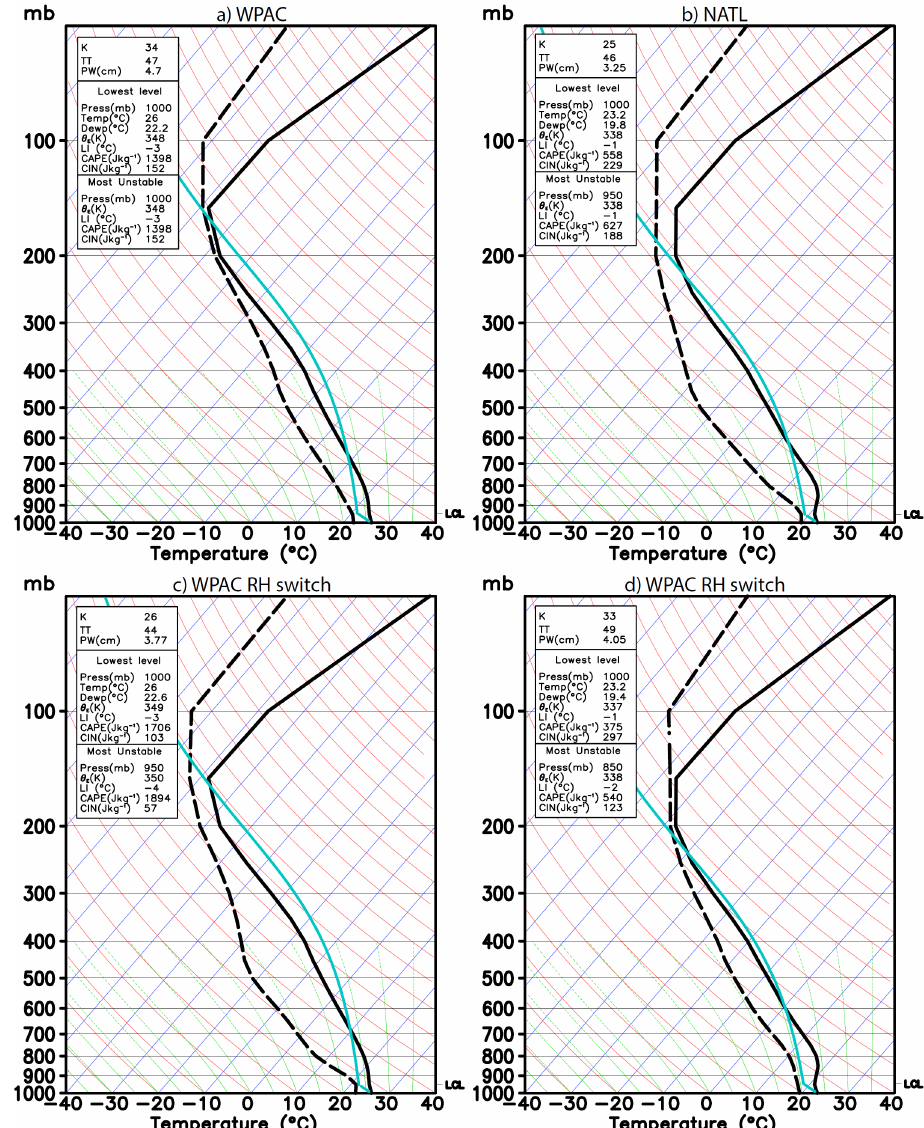
Figure 3. Mean August 2013 sounding profiles for ( a ) the WPAC basin, and ( b ) the NATL basin at initial model time t = 0 that are averaged over a domain given in Table 1 (see Figure 1 for visualization of the spatial domain); ( c , d ) same as ( a , b ) but with the relative humidity (RH) profiles of the input soundings